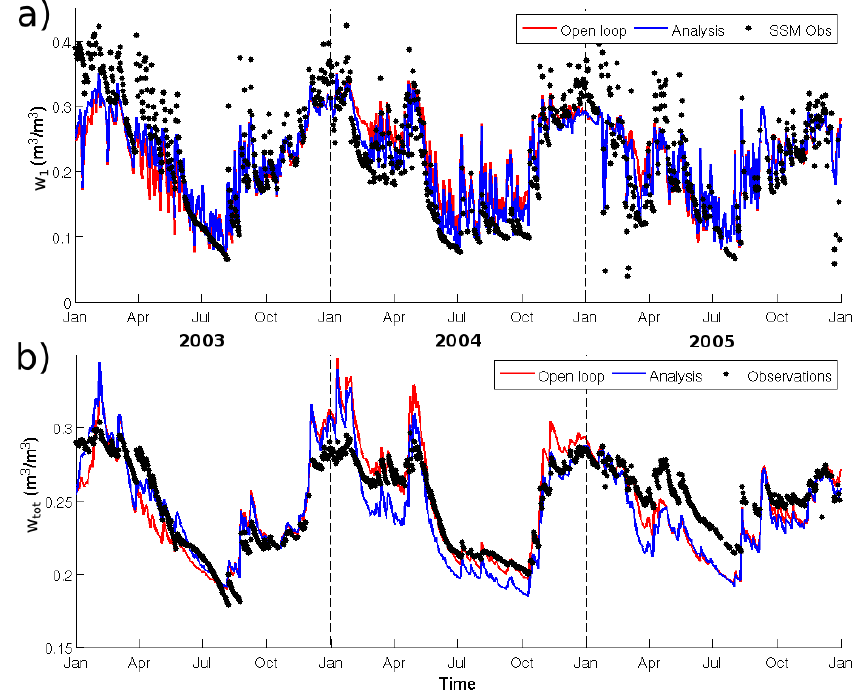
Fig. 7. DF-REF time series of open-loop simulation (red line), analysis simulation (blue line) and SSM observations at the SMOSREX site (black dots) for 2003–2005: in the surface layer (a) and in the total reservoir (b) . The units are in m 3 m − 3